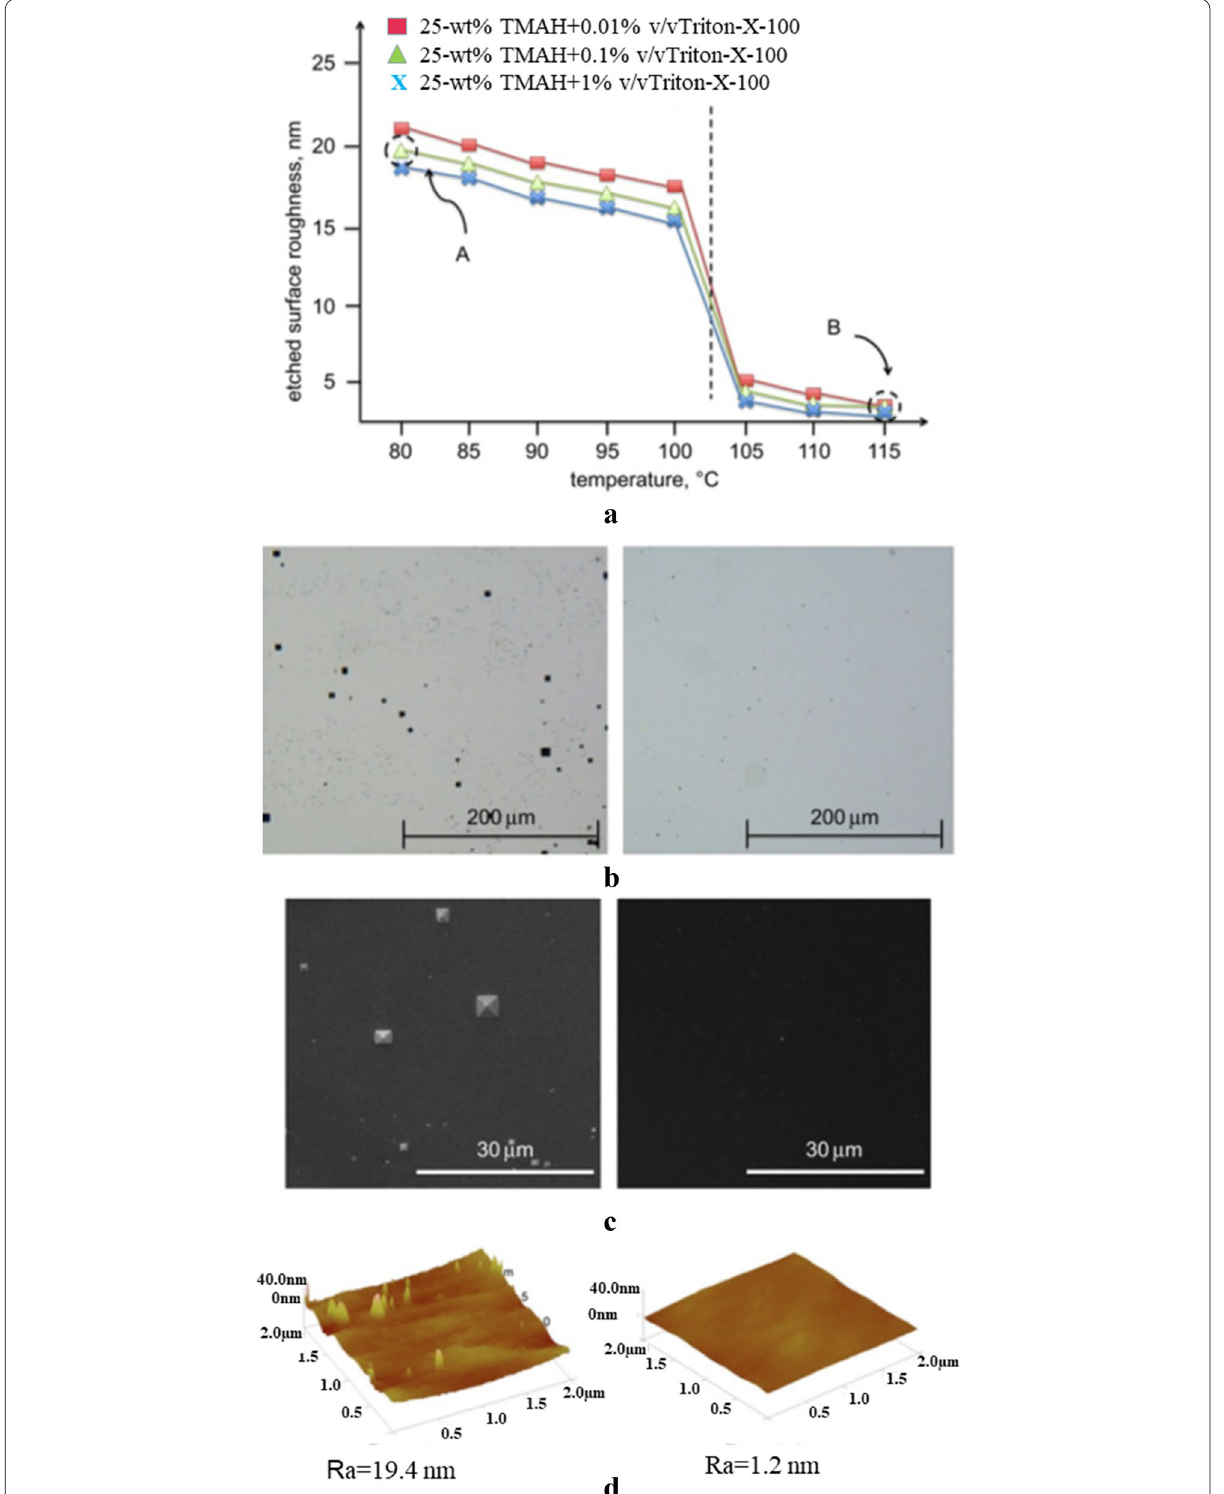
Fig. 21 a Temperature dependent etched surface roughness of Si{100} in 25 wt% TMAH with Triton-X-100 in a volume fraction from 0.01–1%. Etched surface morphologies of the samples corresponding to points A and B: b optical micrographs, c SEM images and d AFM results [69], © 2014,